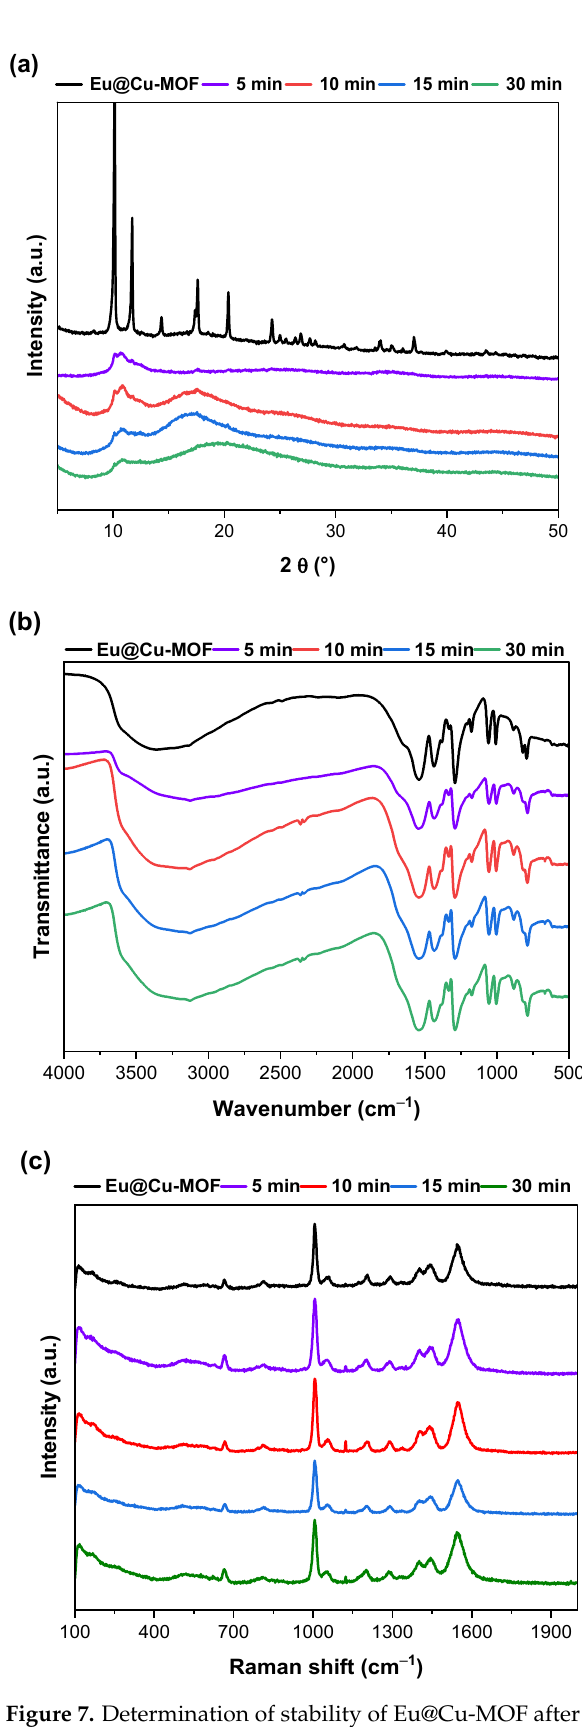
Figure 7. Determination of stability of Eu@Cu-MOF after treatment with AA at a concentration of 7.10 × 10 − 4 M using ( a ) XRD patterns, ( b ) IR, and ( c ) Raman spectroscopies.